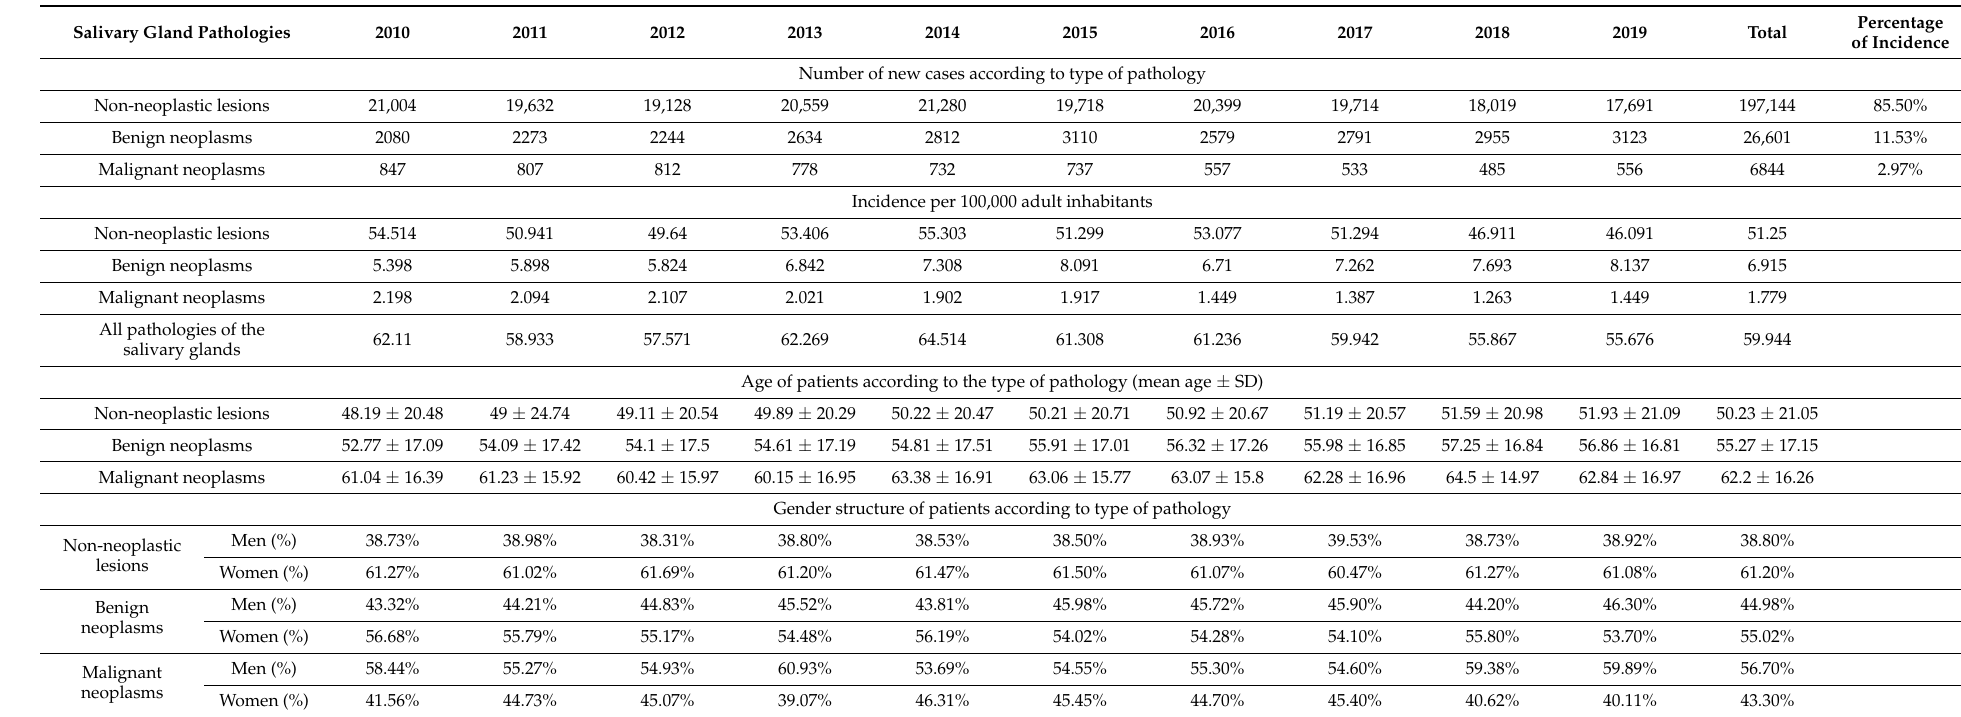
Table 2. Structure of new cases of salivary gland pathologies between 2010 and 2019 in